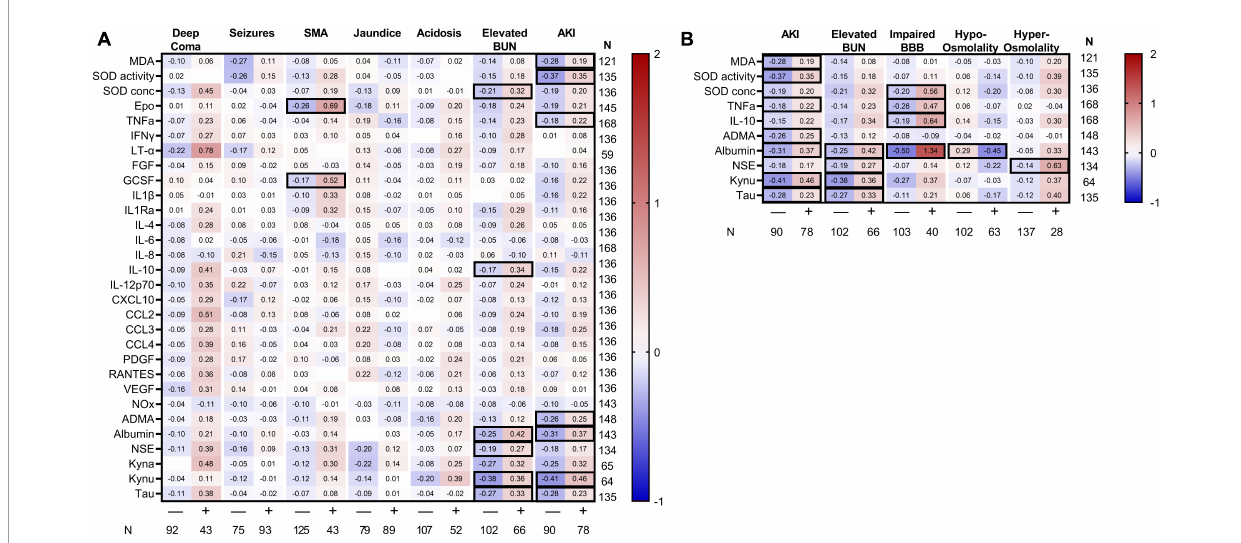
FIGURE3 Heatmap of standardized CSF biomarkers by clinical complications. Mean standardized biomarkers are presented based on clinical complications (header on top) with the number of children with the complications within the cohort presented beneath the figure. Biomarkers are presented along the left y -axis with the number of samples tested presented on the right y -axis. (A) Biomarkers in clinical severe malaria complications. (B) Potential mechanisms of AKI-related changes in markers are depicted based on the presence of elevated BUN, impaired BBB, and changes in osmolality. Differences in standardized biomarkers were evaluated within each clinical complication using a Student’s t -test. Relationships significant following adjustment for multiple testing using Bonferroni correlation are outlined with a black